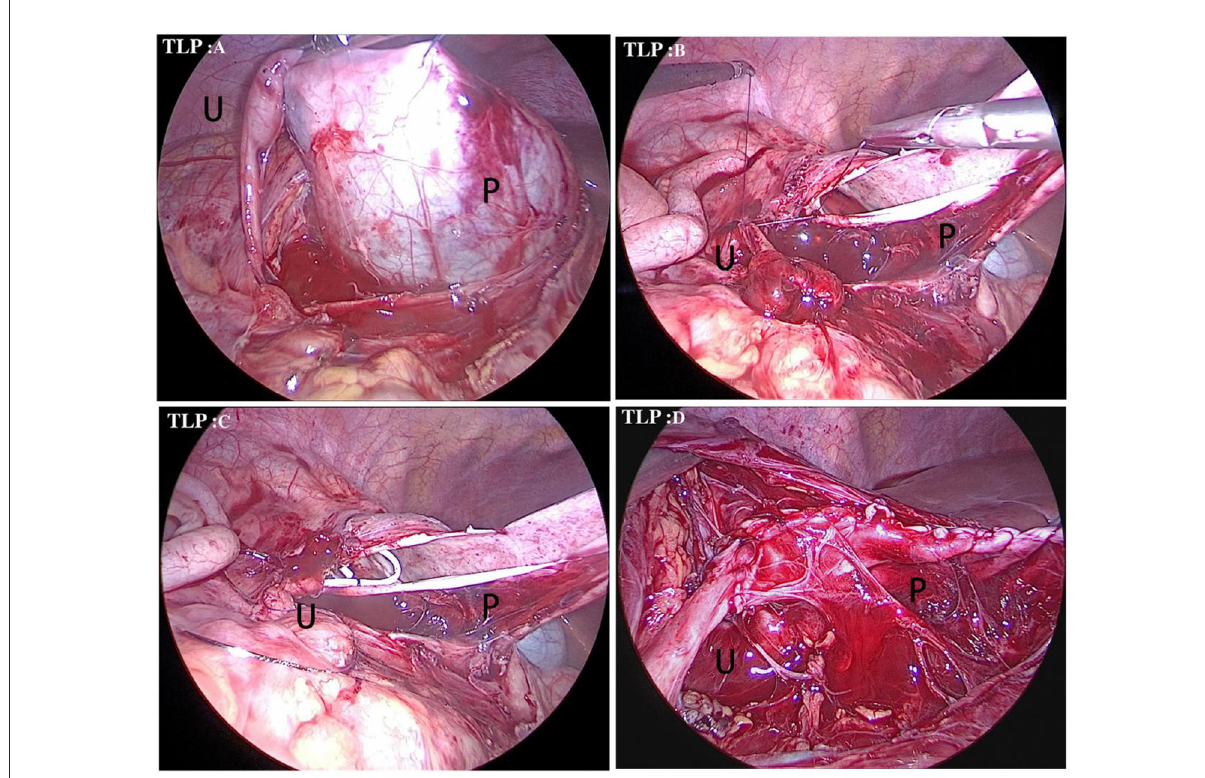
FIGURE2 Surgical procedure of TLP for the treatment of a right-side UPJO. (A) Identifification of the distended renal pelvis (black P) through a paracolonic sulcus. The upper pole of the renal pelvis was suspended and upper ureter (black U) to clarify the location. (B) The anastomosis started between the vertex of spatulated ureter (black U) and the most dependent part of renal pelvis (black P). (C) A double J tube was antegradely introduced through the anastomosis. (D) The remainder of anastomosis was